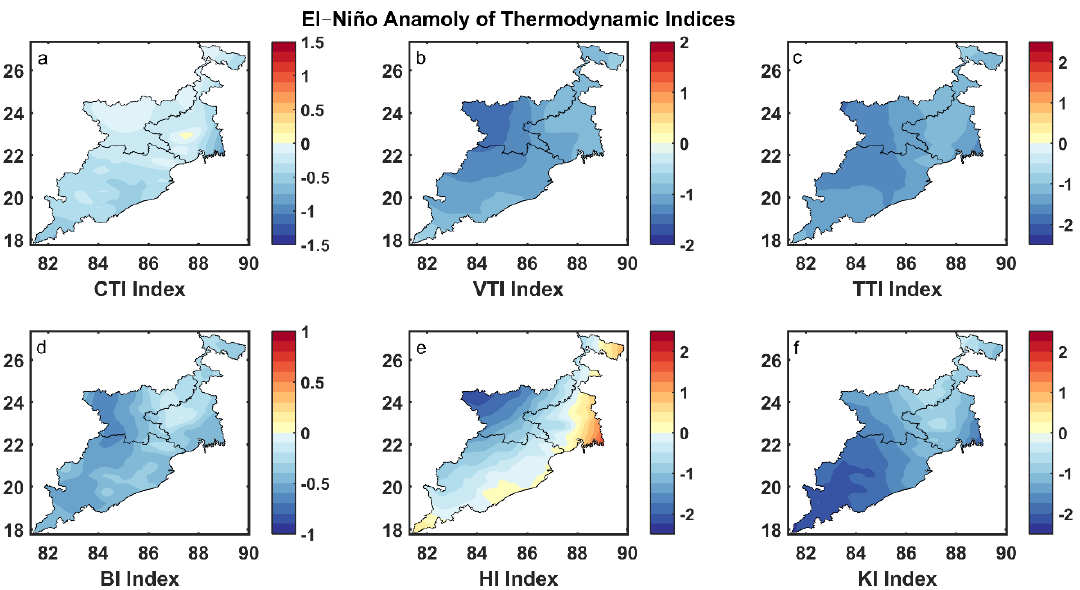
Figure 9. CTI ( a ), VTI ( b ), TTI ( c ), BI ( d ), HI ( e ), KI ( f ) anomalies during El-Niño years from 1987 to 2019.